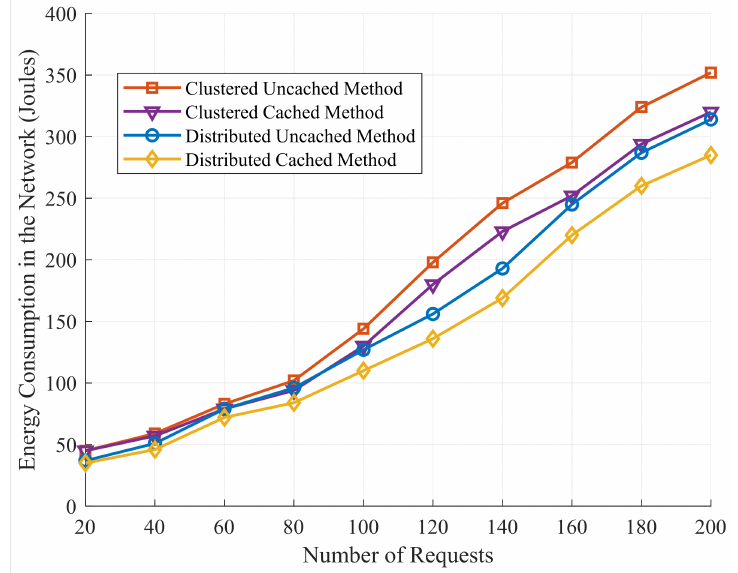
Figure 5. Energy Consumption in the